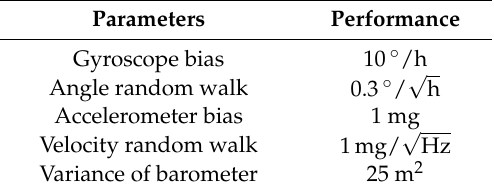
Table 1. Sensor error settings employed in the simulation experiments.